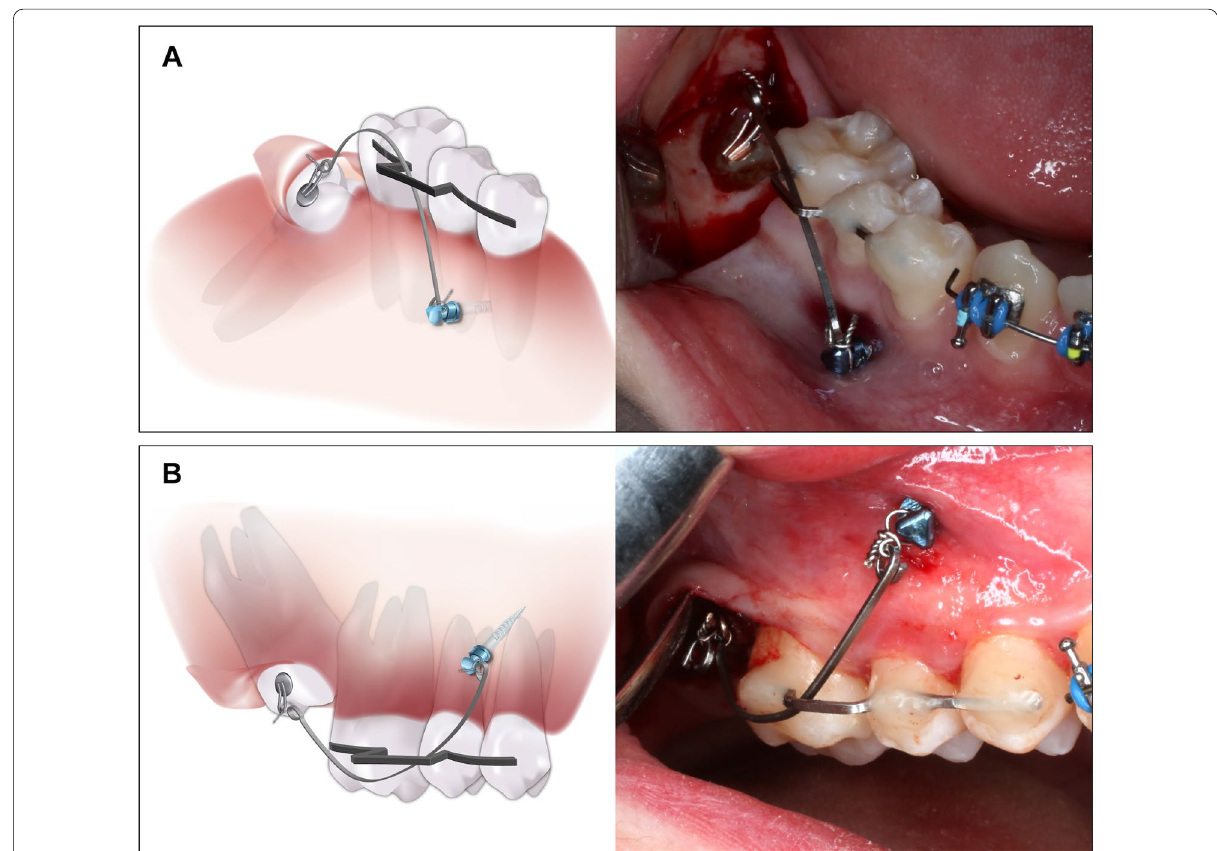
Fig. 2 Diagram and intraoral photograph of the miniscrew‑supported pole technique: a maxillary molar. b mandibular